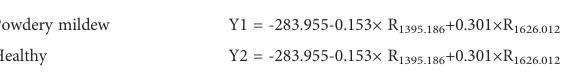
TABLE 3 Recognition model of cucumber powdery mildew in near infrared band.